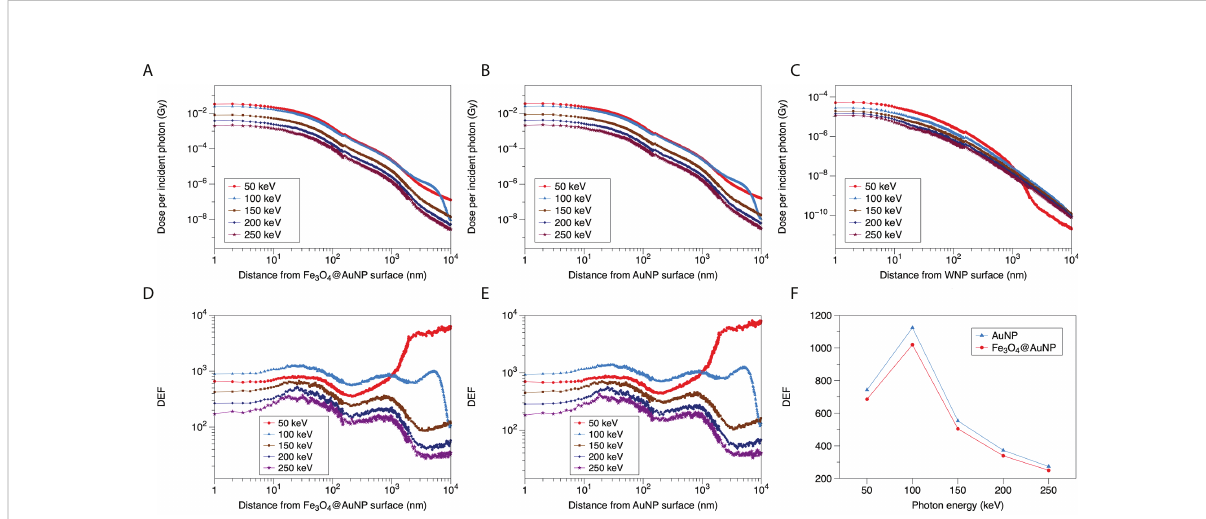
FIGURE 6 Relationship between dose distribution per incident photon and distance from surface of (A) Fe 3 O 4 @AuNP, (B) AuNP, and (C) WNP for 50, 100, 150, 200, and 250 keV photons. DEF distributions around (D) Fe 3 O 4 @AuNP and (E) AuNP as function of distance from the nanoparticle surface. (F) Total DEF around Fe 3 O 4 @AuNP and AuNP in range of 1 to 9.95 × 10 3 nm vs. photon energy.